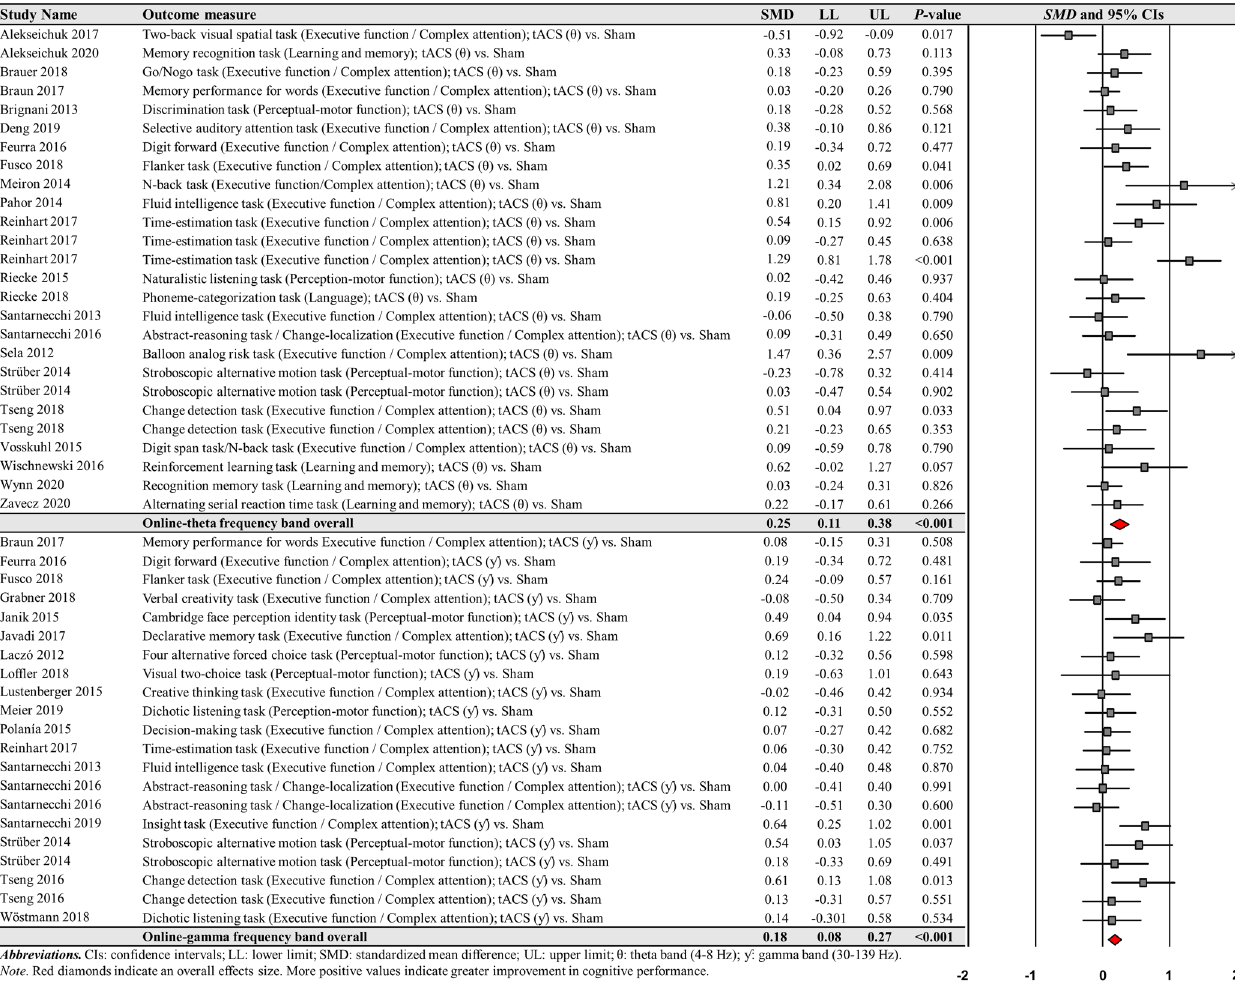
Fig. 5 Cognitive performance comparisons after online-tACS with theta and gamma frequency bands. Meta-analytic fi ndings show potential effects of online-tACS protocols with theta and gamma frequency bands on changes in cognitive